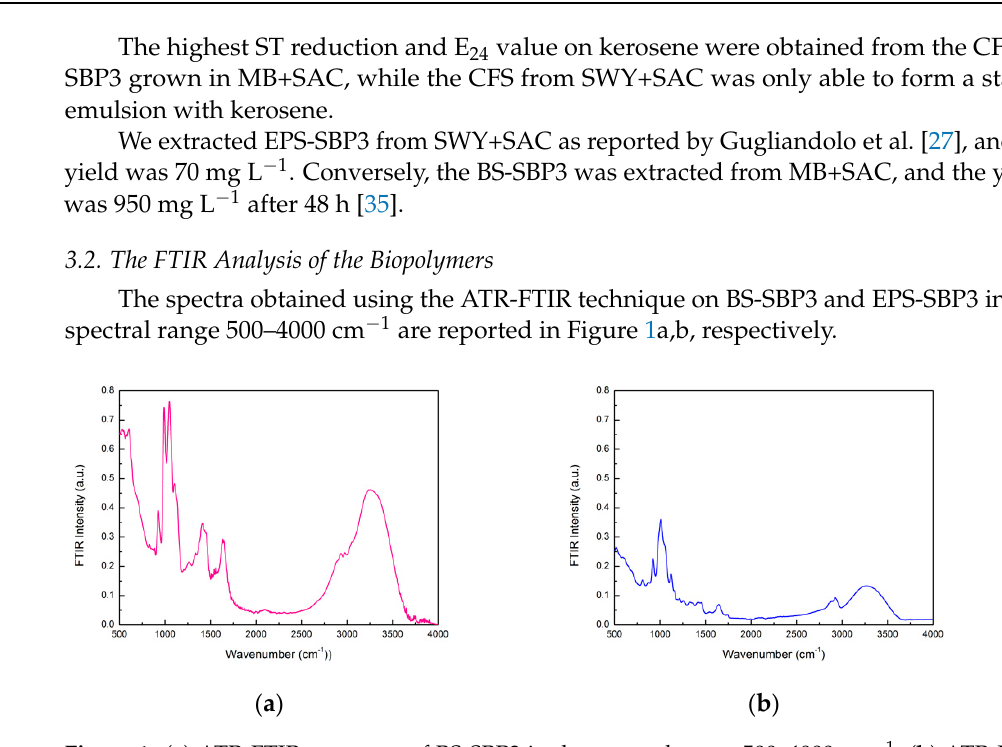
Figure 1. ( a ) ATR-FTIR spectrum of BS-SBP3 in the spectral range 500–4000 cm − 1 ; ( b ) ATR-FTIR spectrum of EPS-SBP3 in the spectral range 500–4000 cm − 1 .